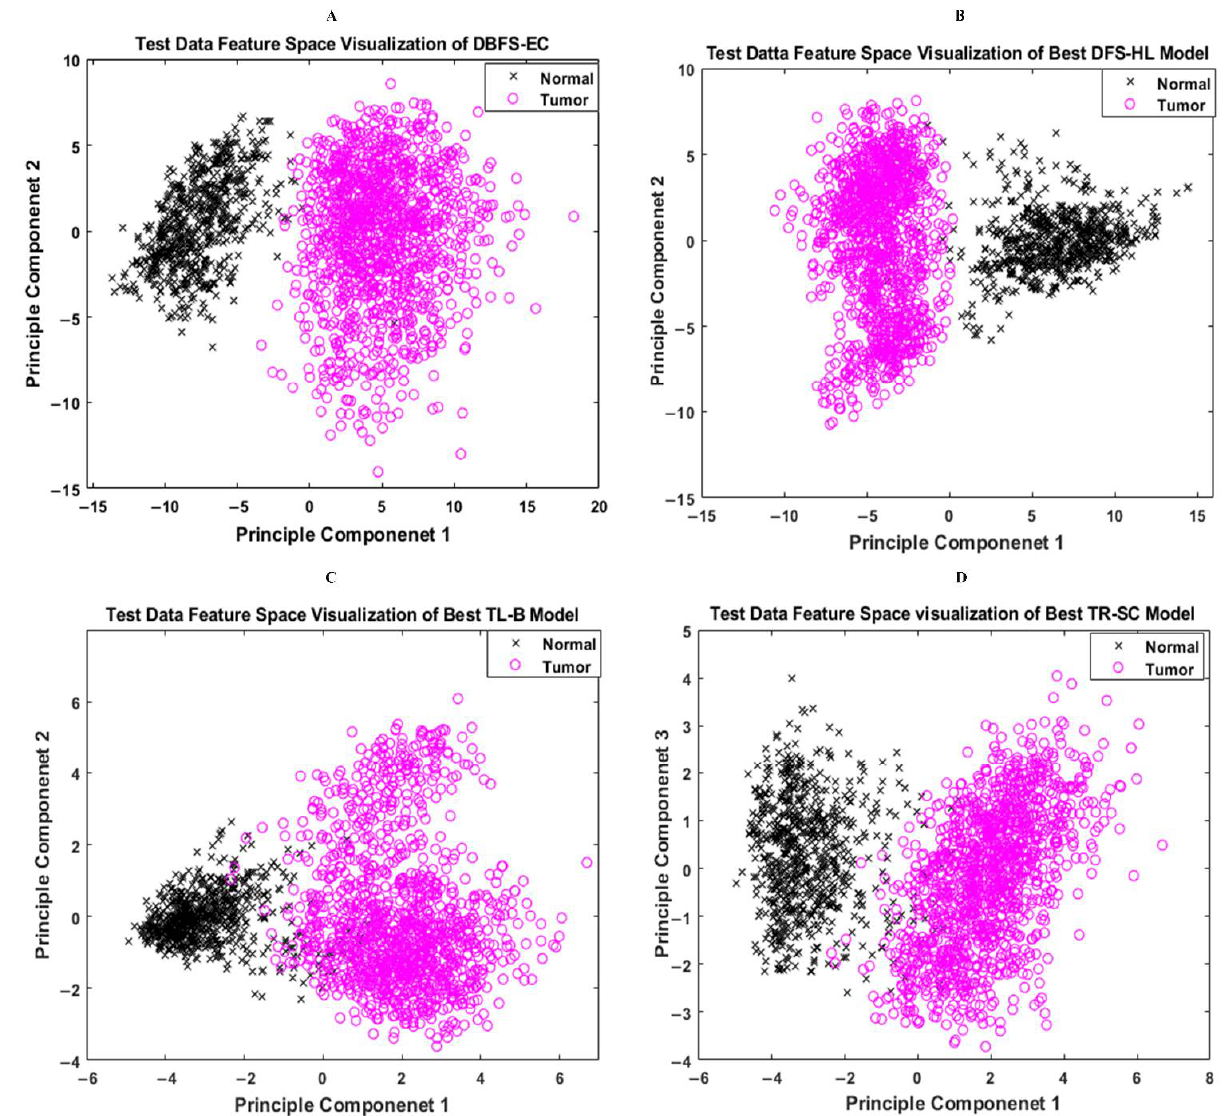
Figure 9. Feature space visualization of the proposed DBFS-EC framework ( A ), DFS-HL ( B ), well- performing TL-B ( C ), and TR-SC ( D ) models.